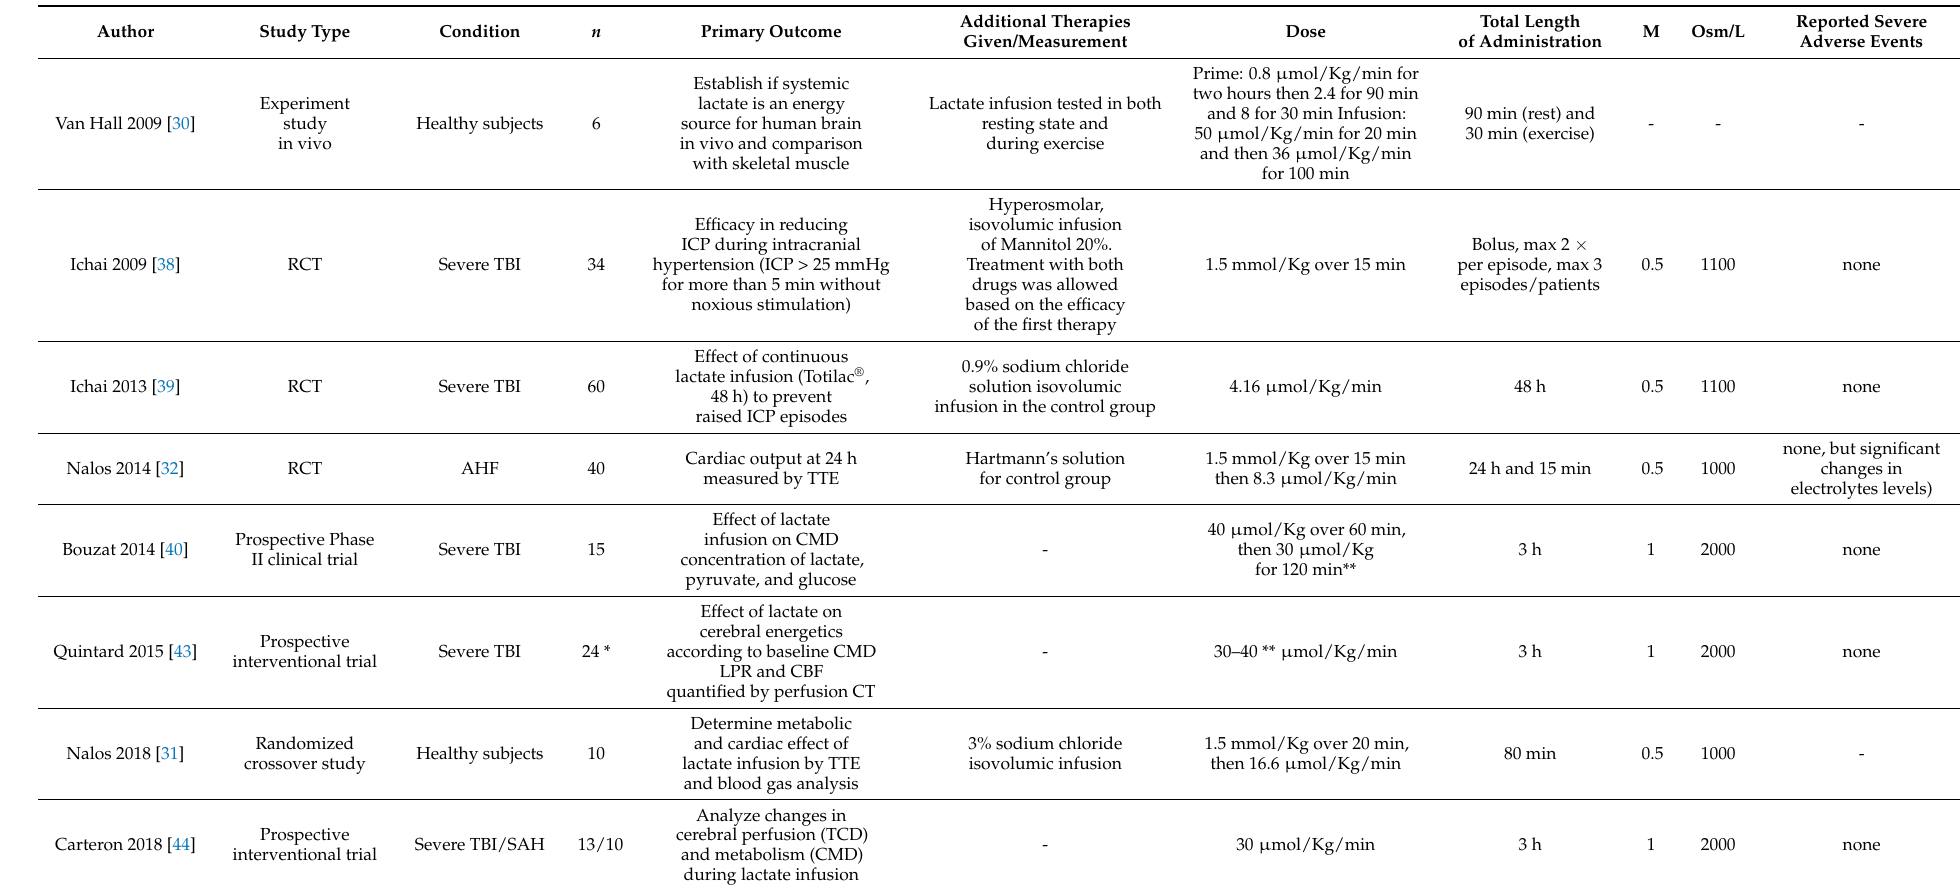
Table 1. Studies in humans with sodium lactate